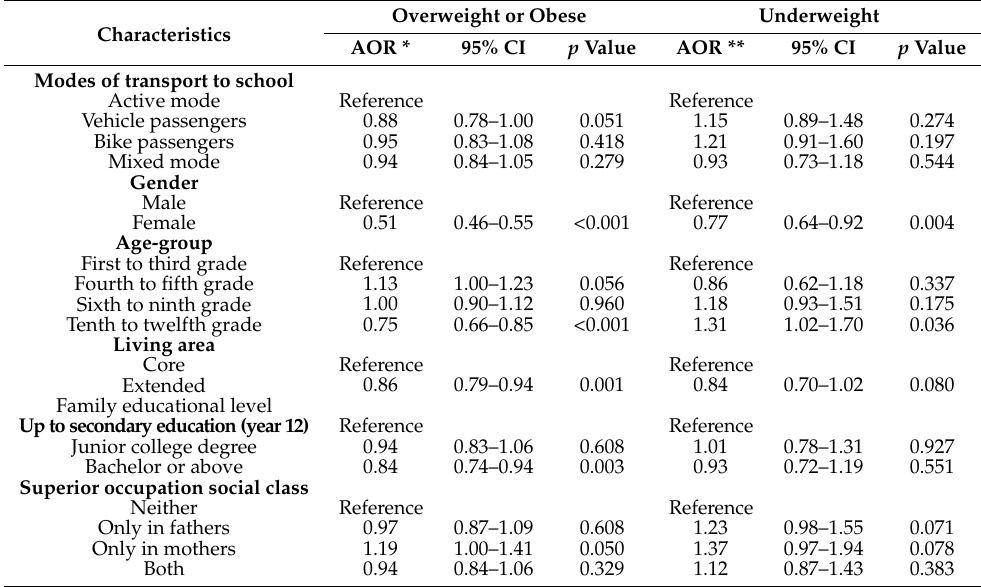
Table 2. Association between modes of transport to school and being underweight, overweight, and obese.